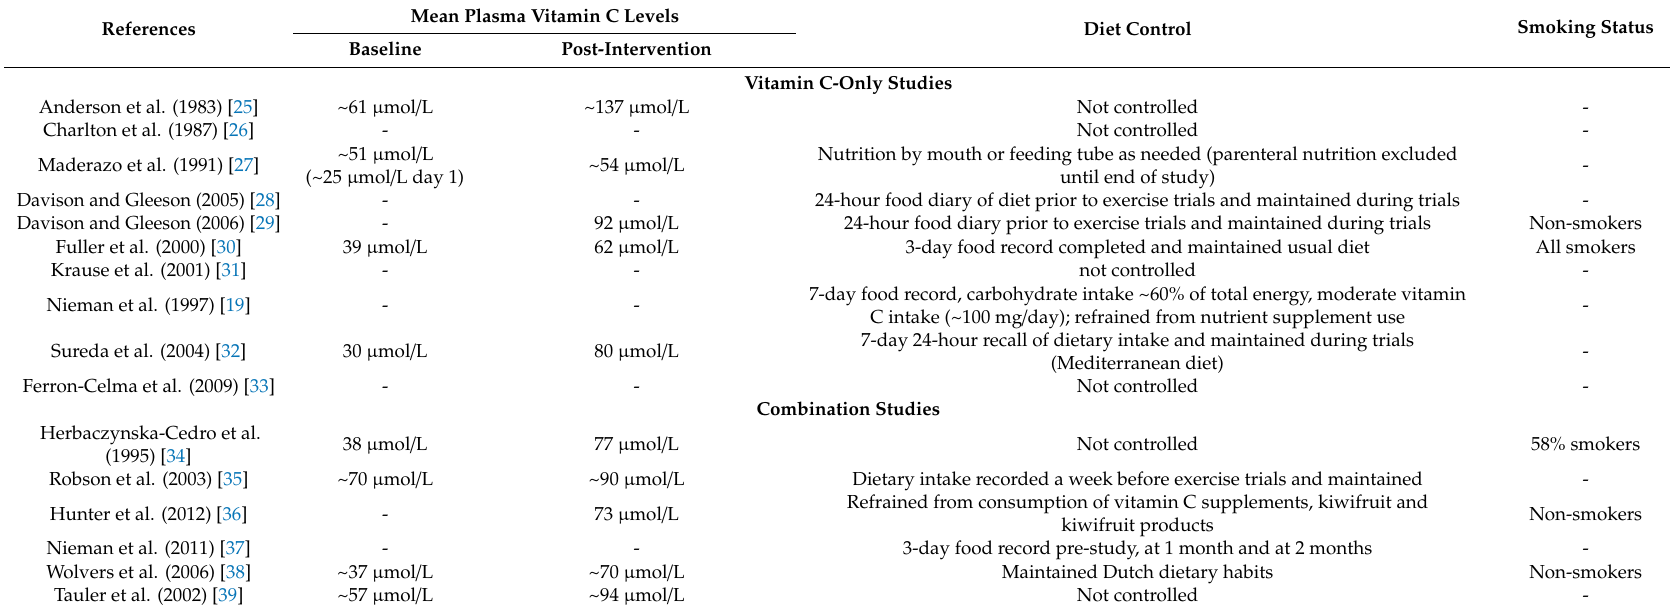
Table 4. Measurement of plasma vitamin C concentrations and control of diet and smoking status within